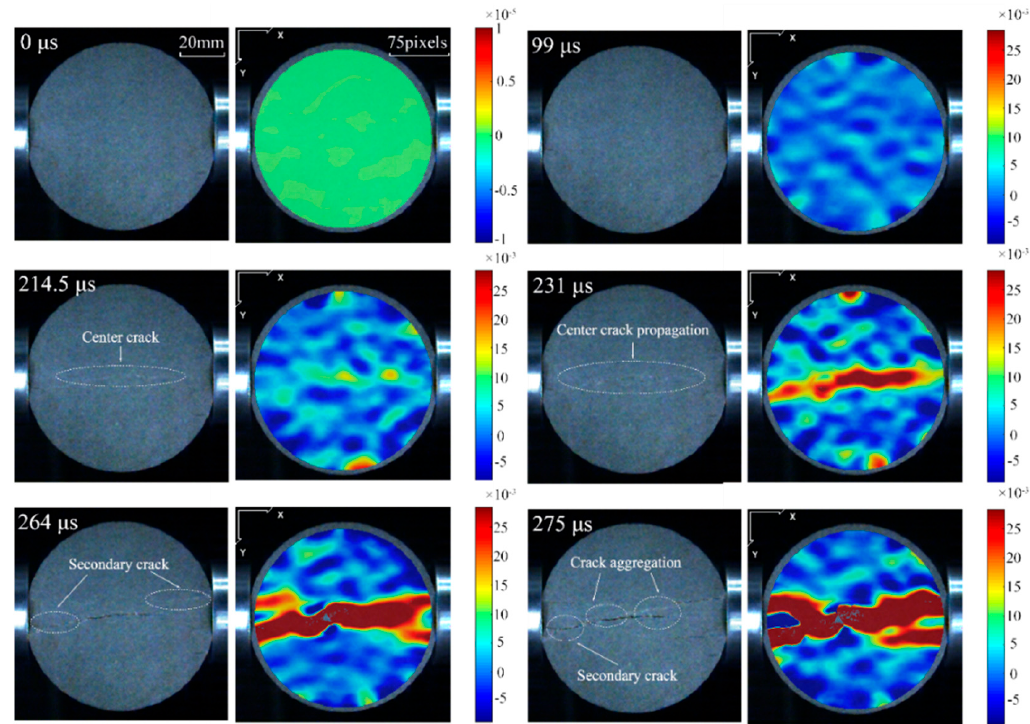
Figure 5. Progressive fracture process of specimen SC-1 under simultaneous dynamic and static loading. Table 2. Coupled static–dynamic FBD test results of naturally saturated sandstone